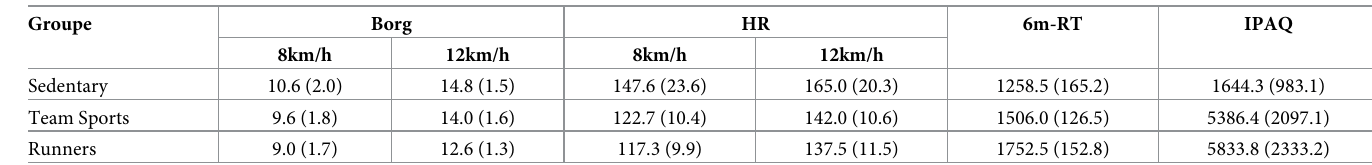
Table 2. Fitness-related variables. Values are means